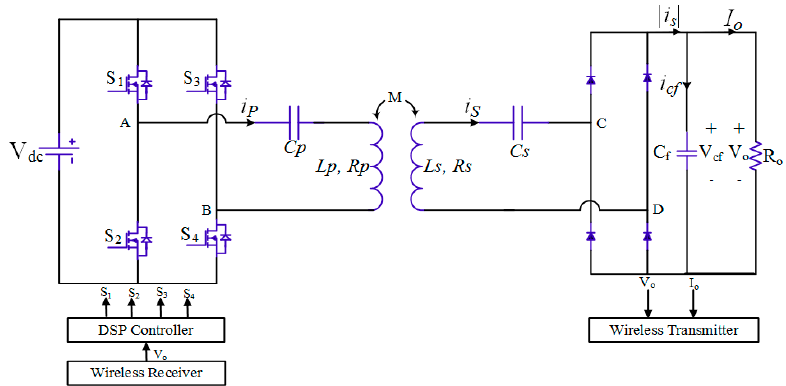
Figure 1. Series-series compensated inductive power transfer system.